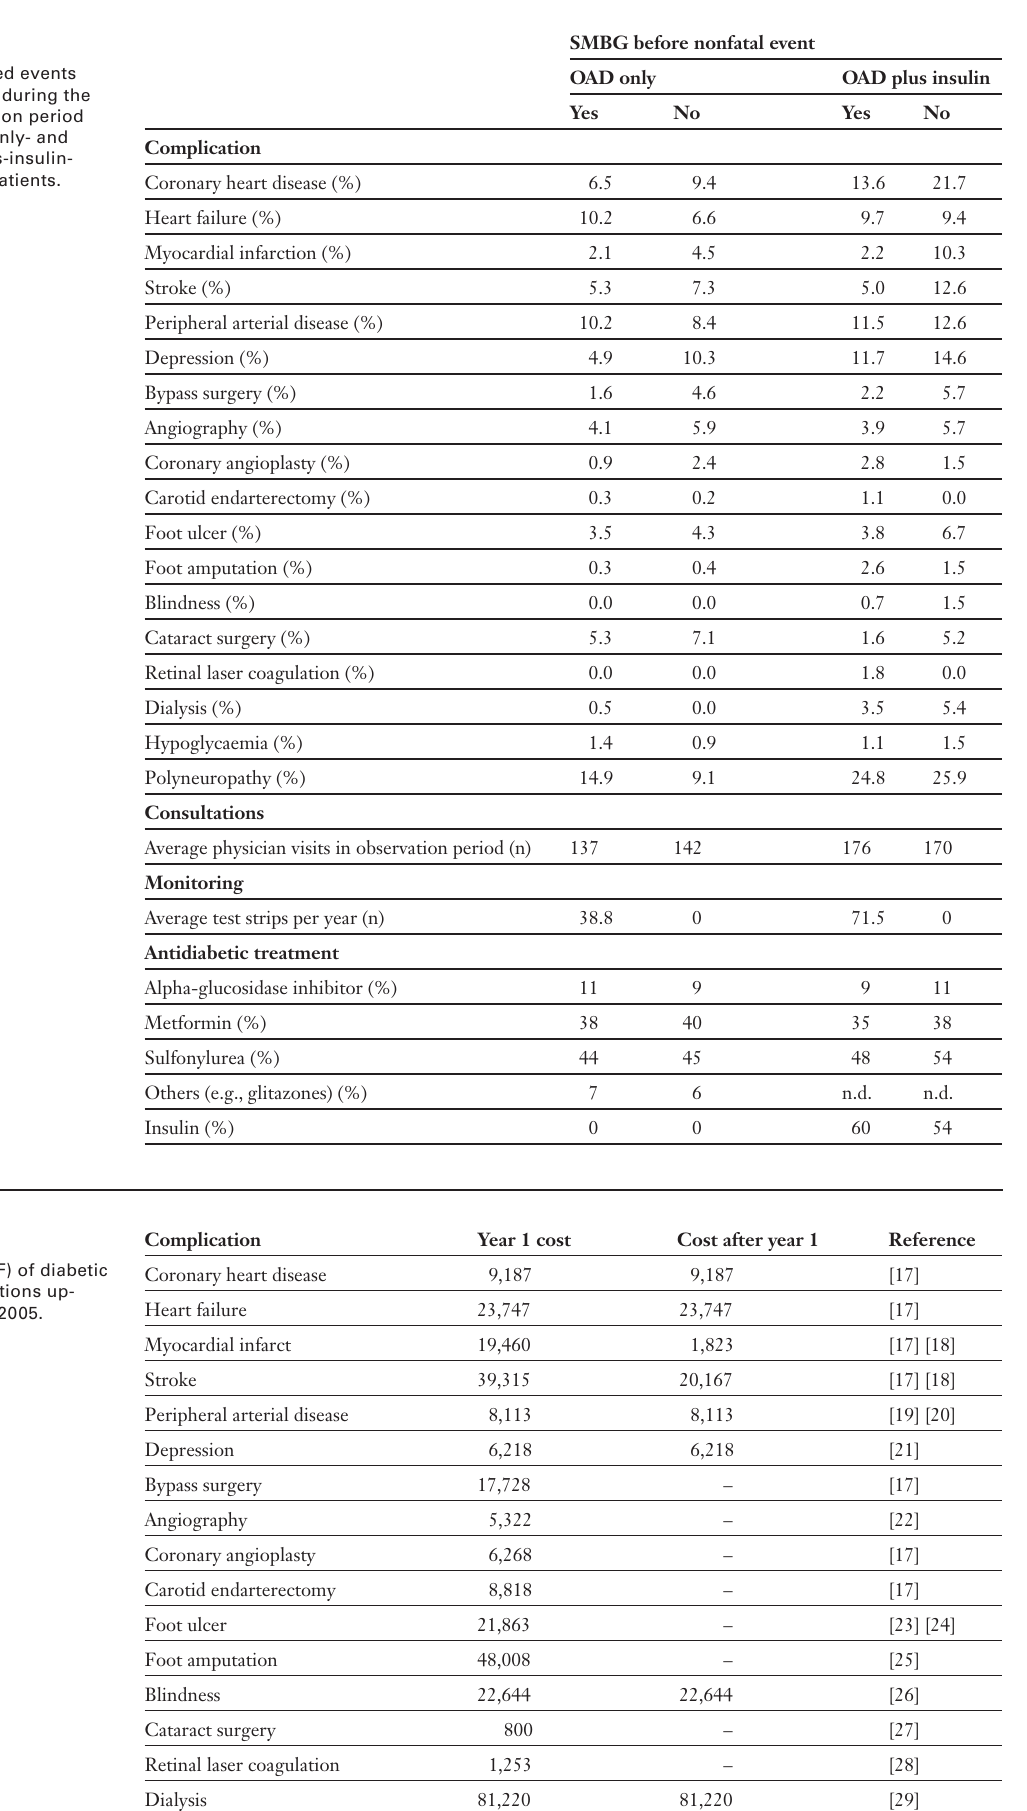
Table 3 Cumulated events occurred during the observation period in OAD-only- and OAD-plus-insulin- treated patients.